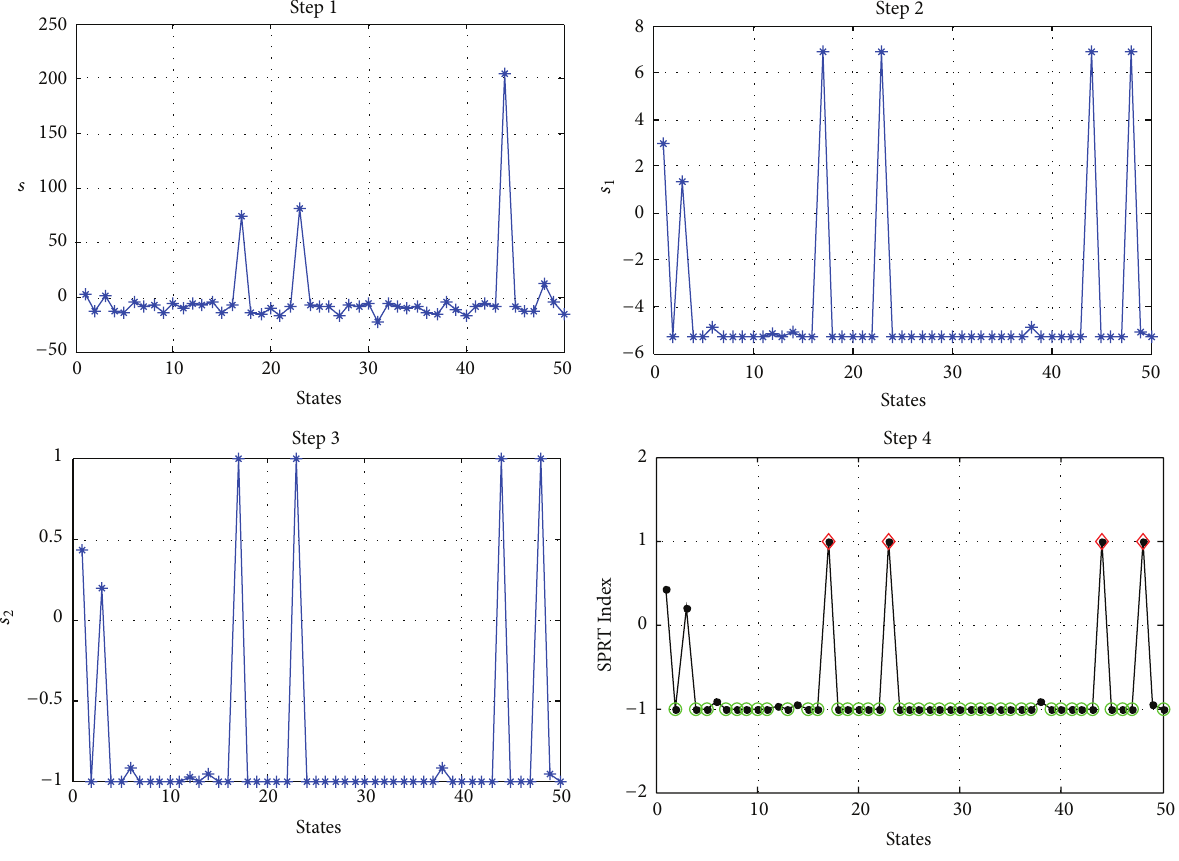
Figure 9: Calculation steps of SPRT